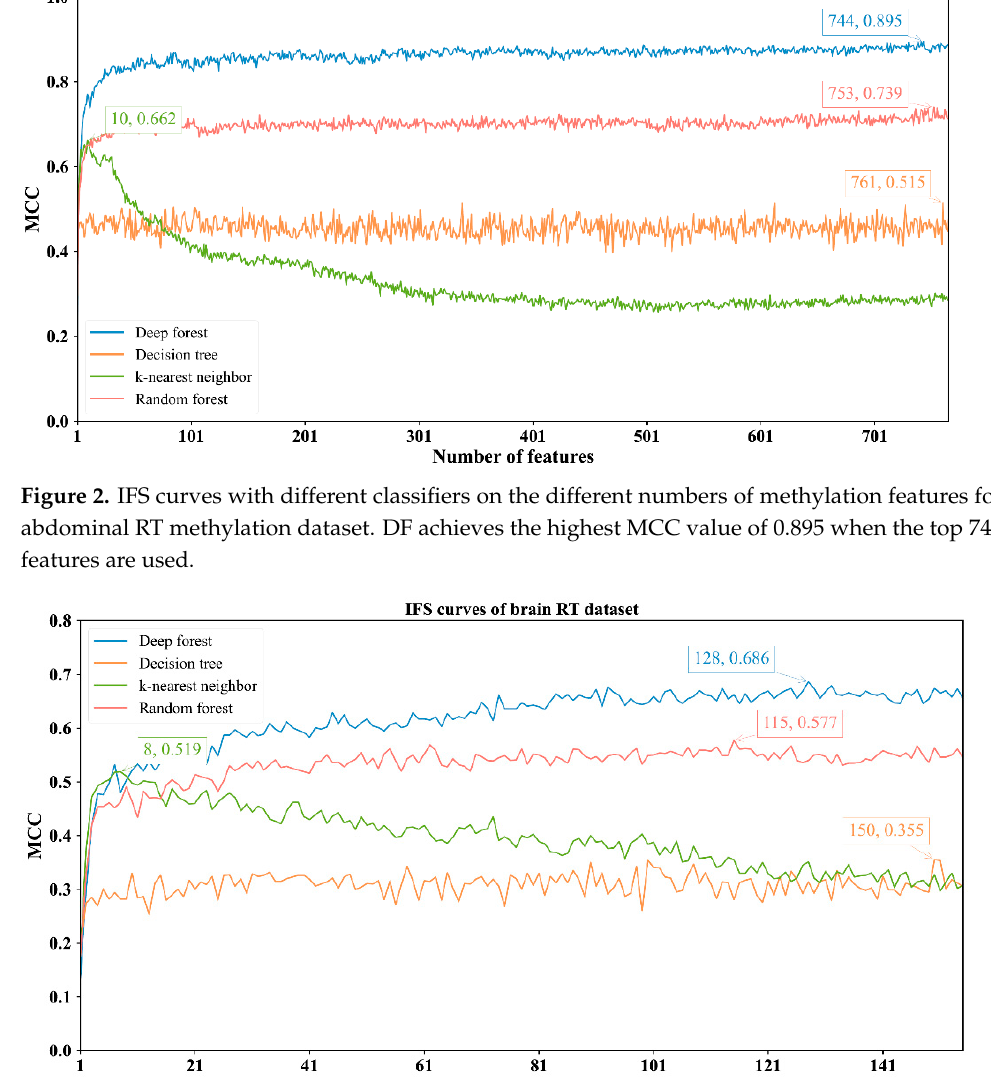
Figure 2. IFS curves with different classifiers on the different numbers of methylation features for abdominal RT methylation dataset. DF achieves the highest MCC value of 0.895 when the top 744 features are used.